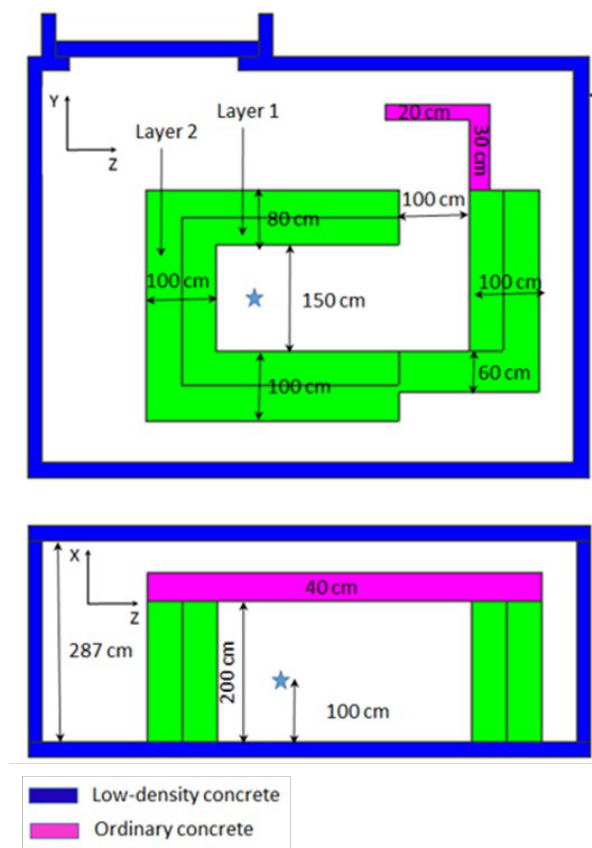
Fig. 6. Top (upper schematic) and side (lower schematic) views of the layout of the shielding for the DT generator. Layer 1 and Layer 2 have been chosen to be either borated polyethylene (5 % boron content) or concrete for different sets of Monte Carlo calculations.